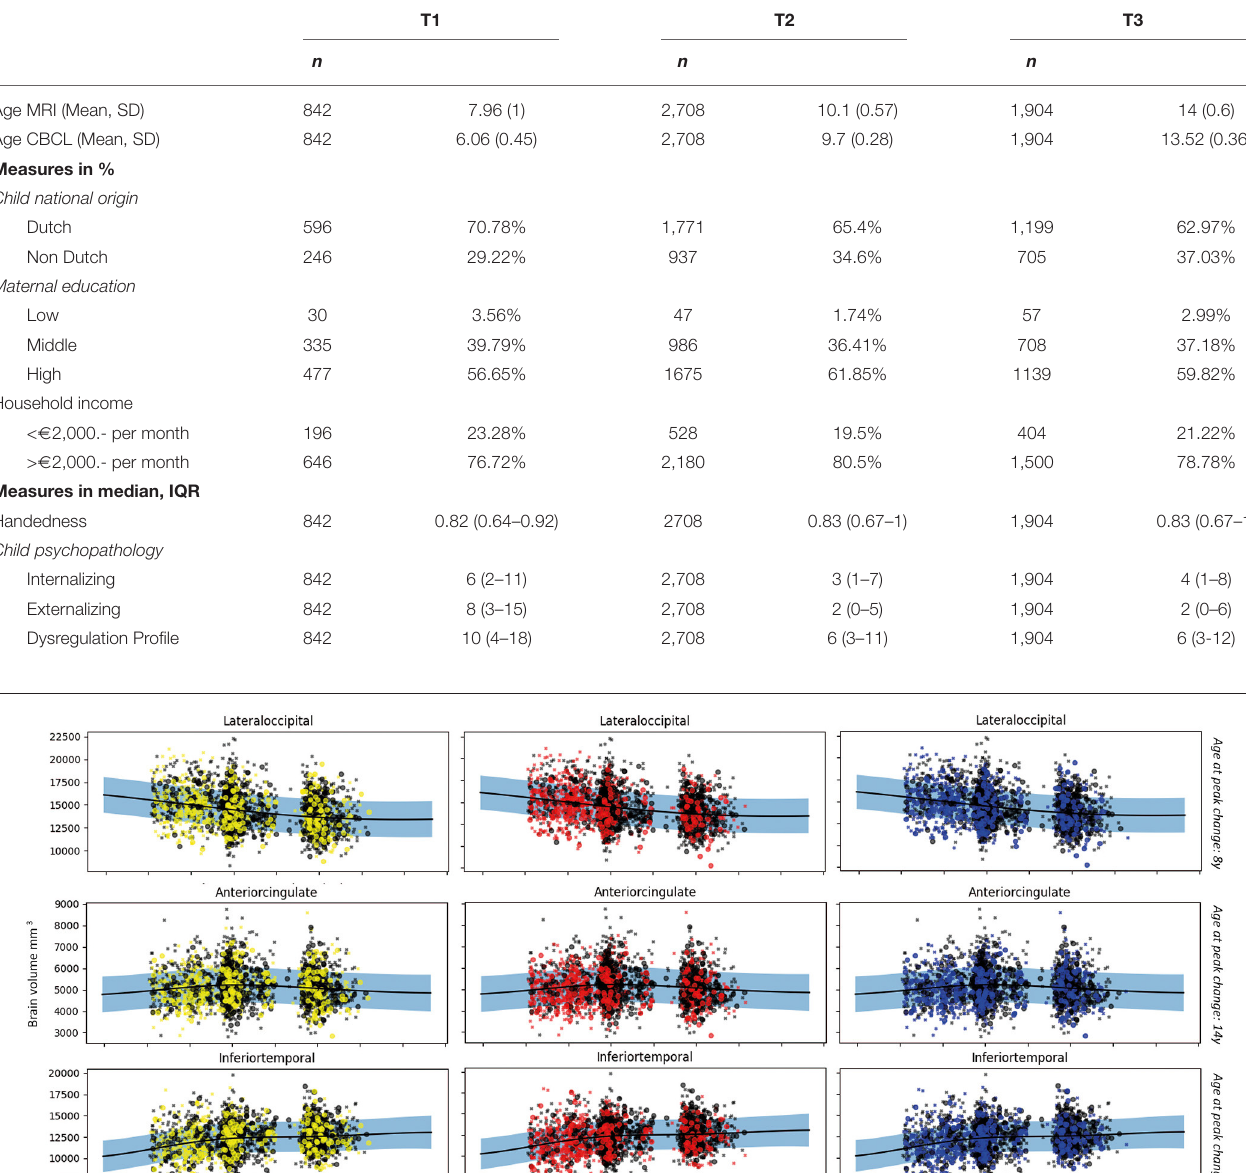
TABLE 1 | Demographic characteristics.